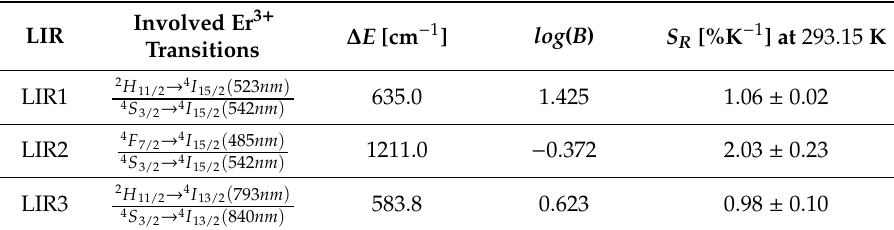
Figure 3. ( a ) The luminescence intensity ratio (LIR) dependence on 1 / kT . Experimental data are given by symbols and the fits by full lines (black: LIR1 – the ratio of 523 and 542 nm emission intensities from 2 H 11 / 2 and 4 S 3 / 2 → 4 I 15 / 2 transitions; red: LIR2 – the ratio of 485 and 542 nm emission intensities from 4 F 7 / 2 and 4 S 3 / 2 → 4 I 15 / 2 transitions; blue: LIR3 – the ratio of 793 and 840 nm emission intensities from 2 H 11 / 2 and 4 S 3 / 2 → 4 I 13 / 2 transitions). The confidence intervals of fits are given by dashed lines, and the R 2 is percentage of variation in the response that is explained by the linear regression model; ( b ) relative sensitivities of LIRs on temperature (black line – LIR1, red line – LIR2, and blue line – LIR3). At 293 K, relative sensitivity values, see Figure 3b, are 1.06 ± 0.02 (LIR1), 2.03 ± 0.23 (LIR2), and 0.98 ± 0.10%K − 1 (LIR3). The LIR utilizing NIR upconversion emissions (LIR3) shows 0.87 ± 0.09%K − 1 @310 K in the physiologically relevant range of temperatures (303–348 K range, which is relevant for biomedical applications of luminescence thermometry). Table 1. The fitting parameters of experimental luminescence intensity ratio (LIR) data from Figure 2 + log ( B ) function. Values of relative sensitivities, S to the log ( LIR ) = − ∆ E · 1 R , are calculated using kT Equation